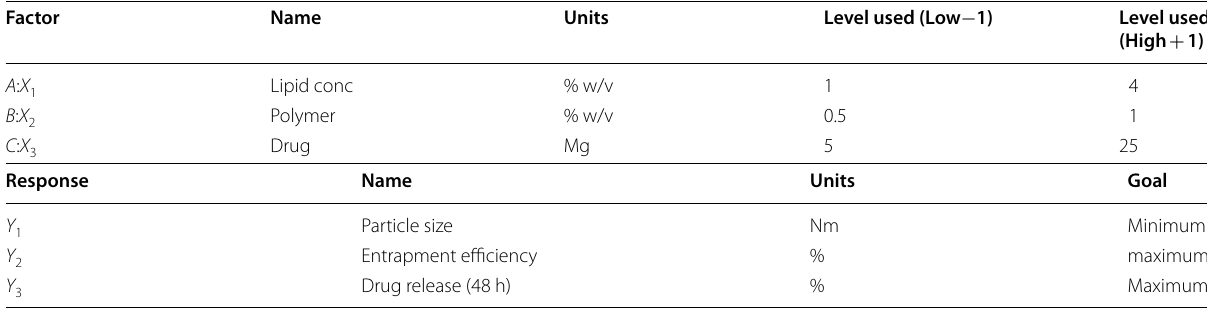
Table 1 The formulation factors and responses of Box–Behnken design for gallic acid nanoparticle